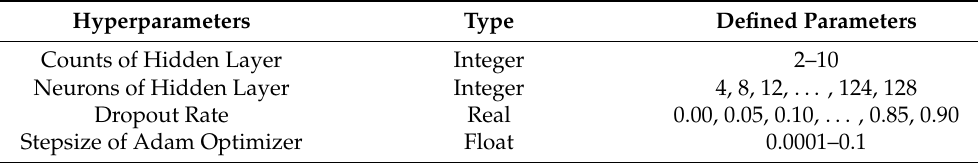
Table 2. The range of hyperparameters for the model